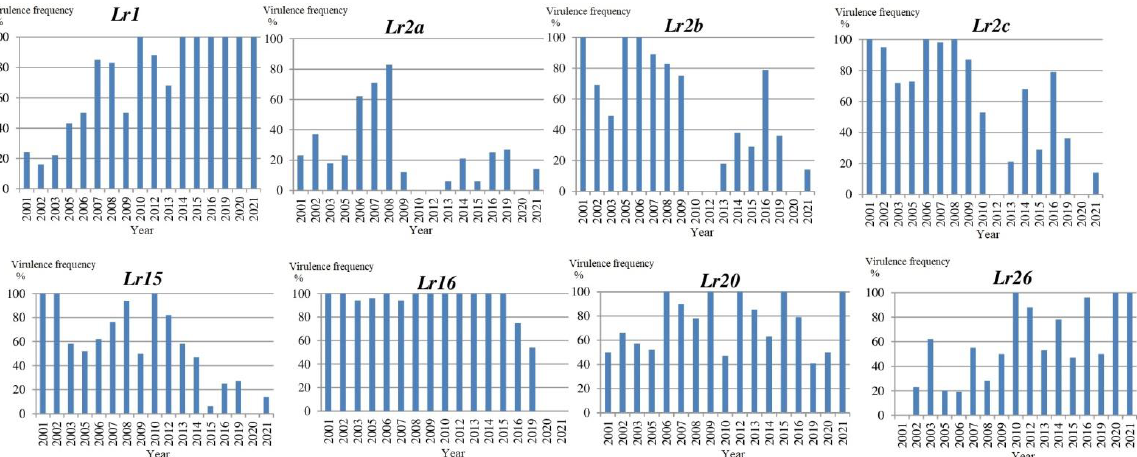
Figure 2. Frequencies of isolates of Puccinia triticina in North-Western Region of Russia in 2001–2021 virulent to Thatcher wheat lines with single genes for resistance (%).